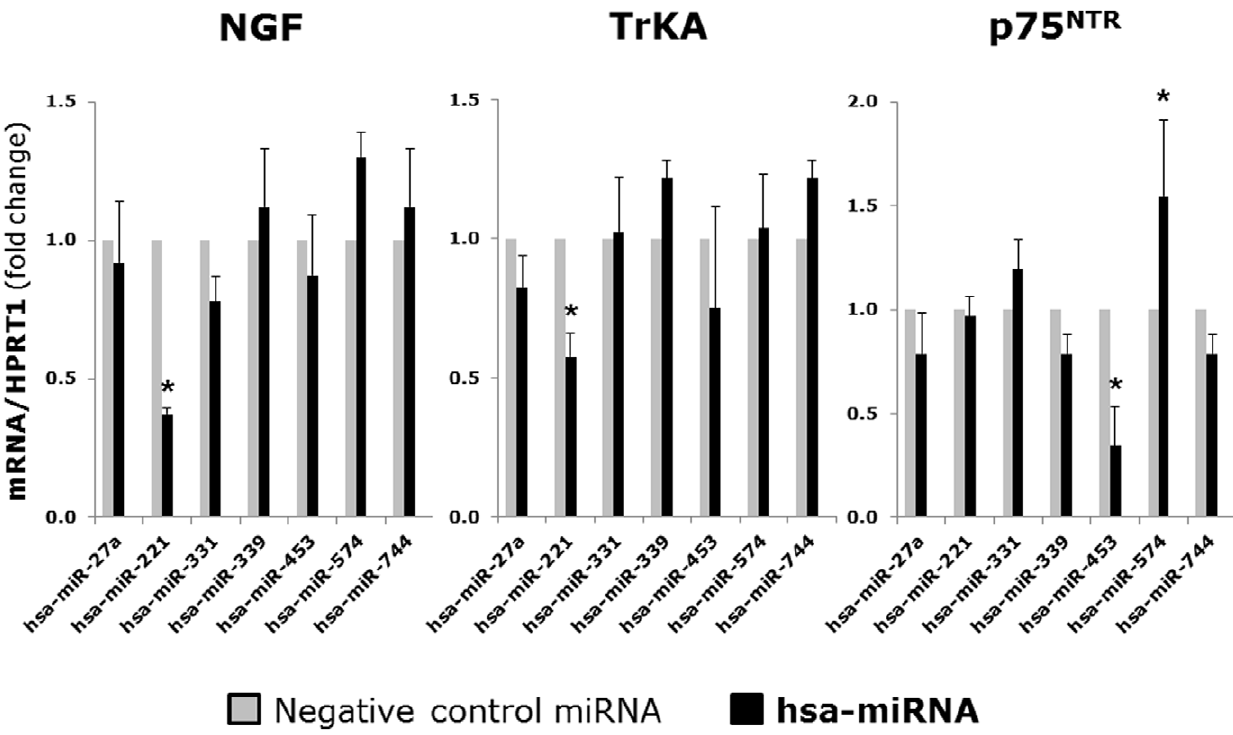
Figure 2. Gene expression in bronchial cells transfected with microRNAs. Homo sapiens (hsa)-miRNAs with a high degree of homology to mRNAs encoding neurotrophic factors or receptors were selected from our microarray dataset, and mimic oligonucleotides of the precursors for each of these miRNAs were transfected into human bronchial epithelial cells to study their individual role in modulating neurotrophin expression. PCR measured maximally reduced concentrations of both NGF and TrKA transcripts in bronchial epithelial cells overexpressing miR-221. Data are expressed as the mean 6 SEM (n=3–4 per group). *=p , 0.01 compared to cells transfected with the negative control miRNA. doi:10.1371/journal.pone.0030030.g002 PLoS ONE |